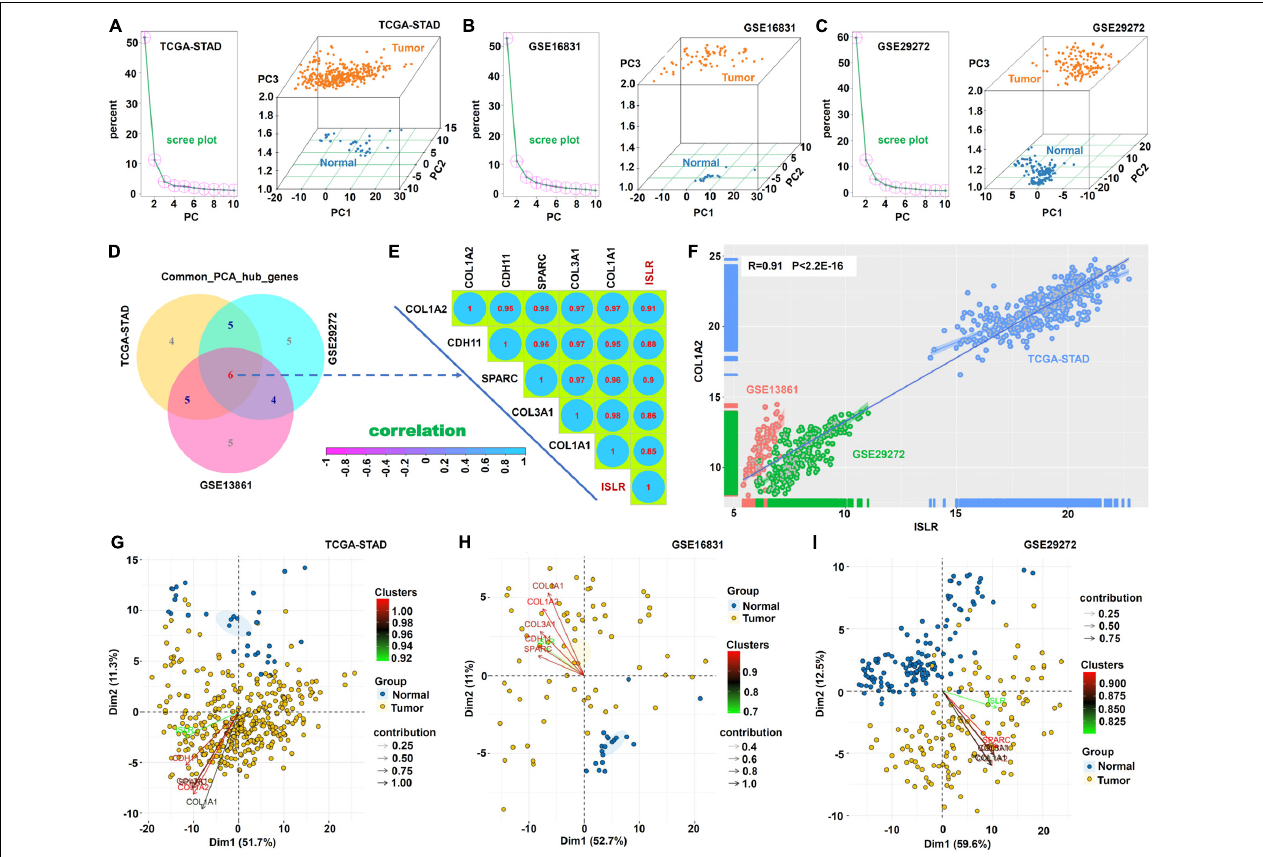
FIGURE 8 | Principal component analysis. Based on the common_POS_genes and common_NEG_genes, the prcomp () function was used for PCA to classify the normal and tumor sections in TCGA-STAD (A) , GSE13861 (B) , and GSE29272 (C) . A scree plot and a three-dimensional map (PC1, PC2, and PC3) are provided. (D) The “VennDiagram” R package was used for the common_PCA_hub_genes. (E) The cor () function and “corrplot” R package were used for the Spearman correlation analysis of these hub genes. Correlation coefficients are shown. (F) The scatter plot for the correlation between ISLR and COL1A2 gene expression is provided. (G–I) The “factoextra” R package was utilized to show the principal component weight and two-dimensional contribution maps of common hub